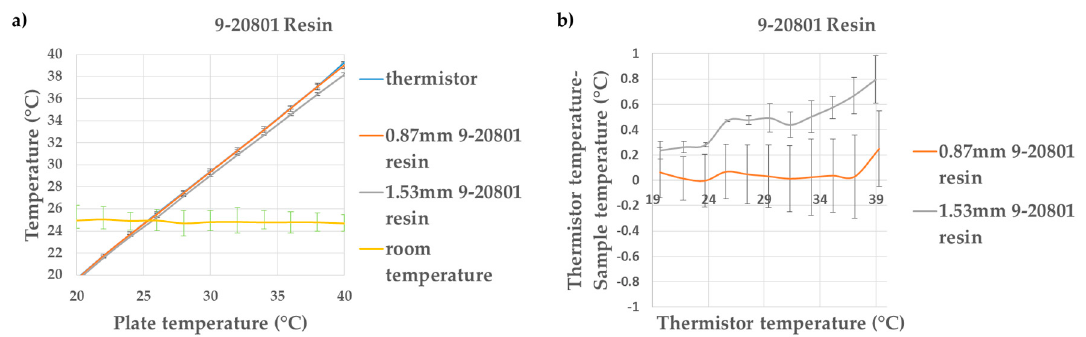
Figure 3. Thermistor samples encapsulated within resin micro-pods created with 9-20801 resin. ( a ) The effect of increasing the plate temperature on the temperature recorded by the thermistor and the samples (0.87 mm 9-20801 resin and 1.53 mm 9-20801 resin); ( b ) The difference between the temperature recorded by the samples compared to the thermistor temperature, showing the deviations from the expected values.